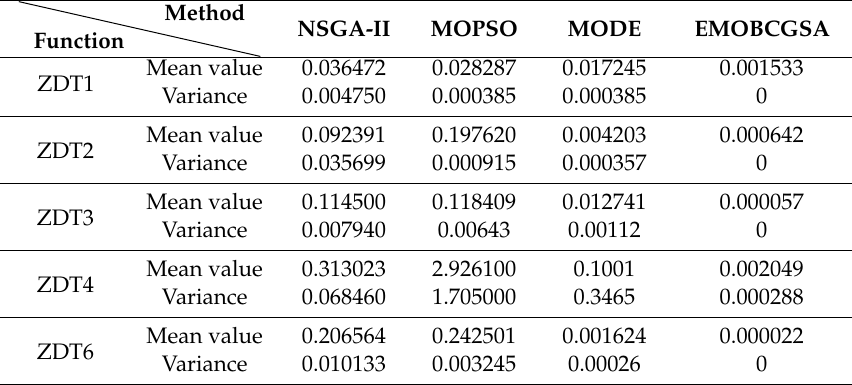
Table 1. Convergence index.